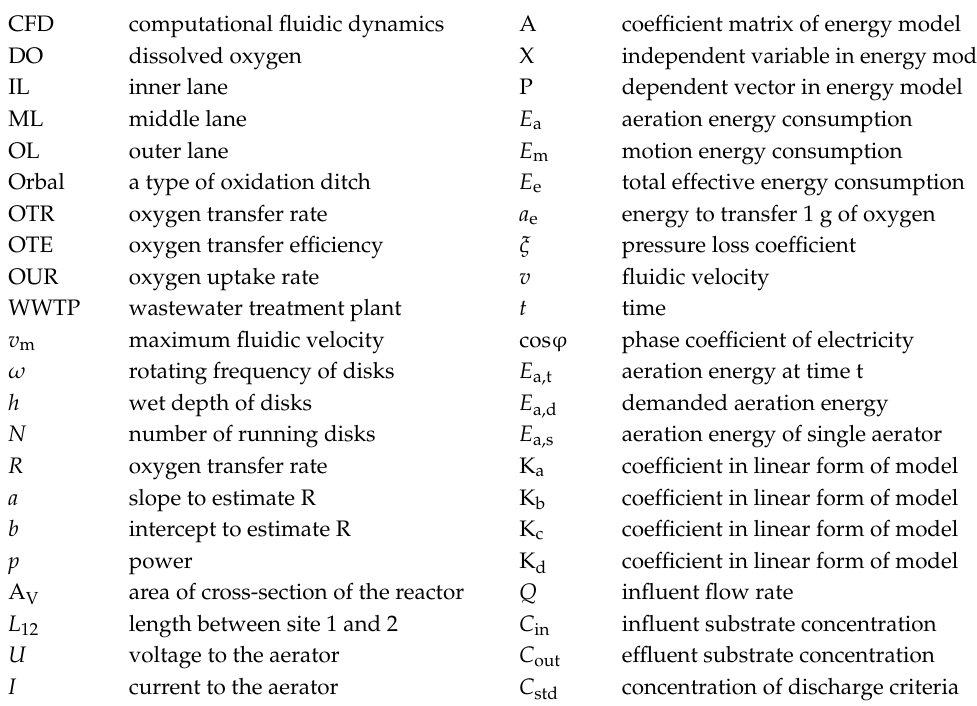
Figure S1: Dissolved oxygen (DO) profiles along the outer-lane reactor, Figure S2: Profiles of OUR and ammonia along the reactor. OL, ML and IL mean the outer, middle and inner lane respectively. OL-1, OL-2 and OL-3 represent the three sampling sites evenly distributed along the OL, which is the same for ML and IL. Eff represents the sampling site at the effluent weir. Error bars shows the standard deviation of OUR ( n = 10) and ammonia ( n = 3), Table S1: Parameter estimation for energy model and surface aerator model, Table S2: The components of total investment on the control system retrofitting, Table S3: Estimated cost and benefits of the operation of control